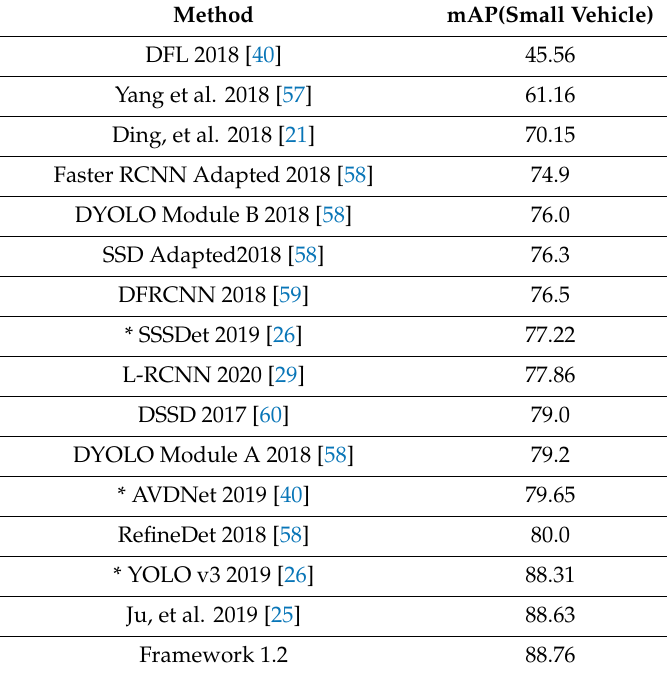
Table 5. Comparison between proposed framework and other methods on DOTA.